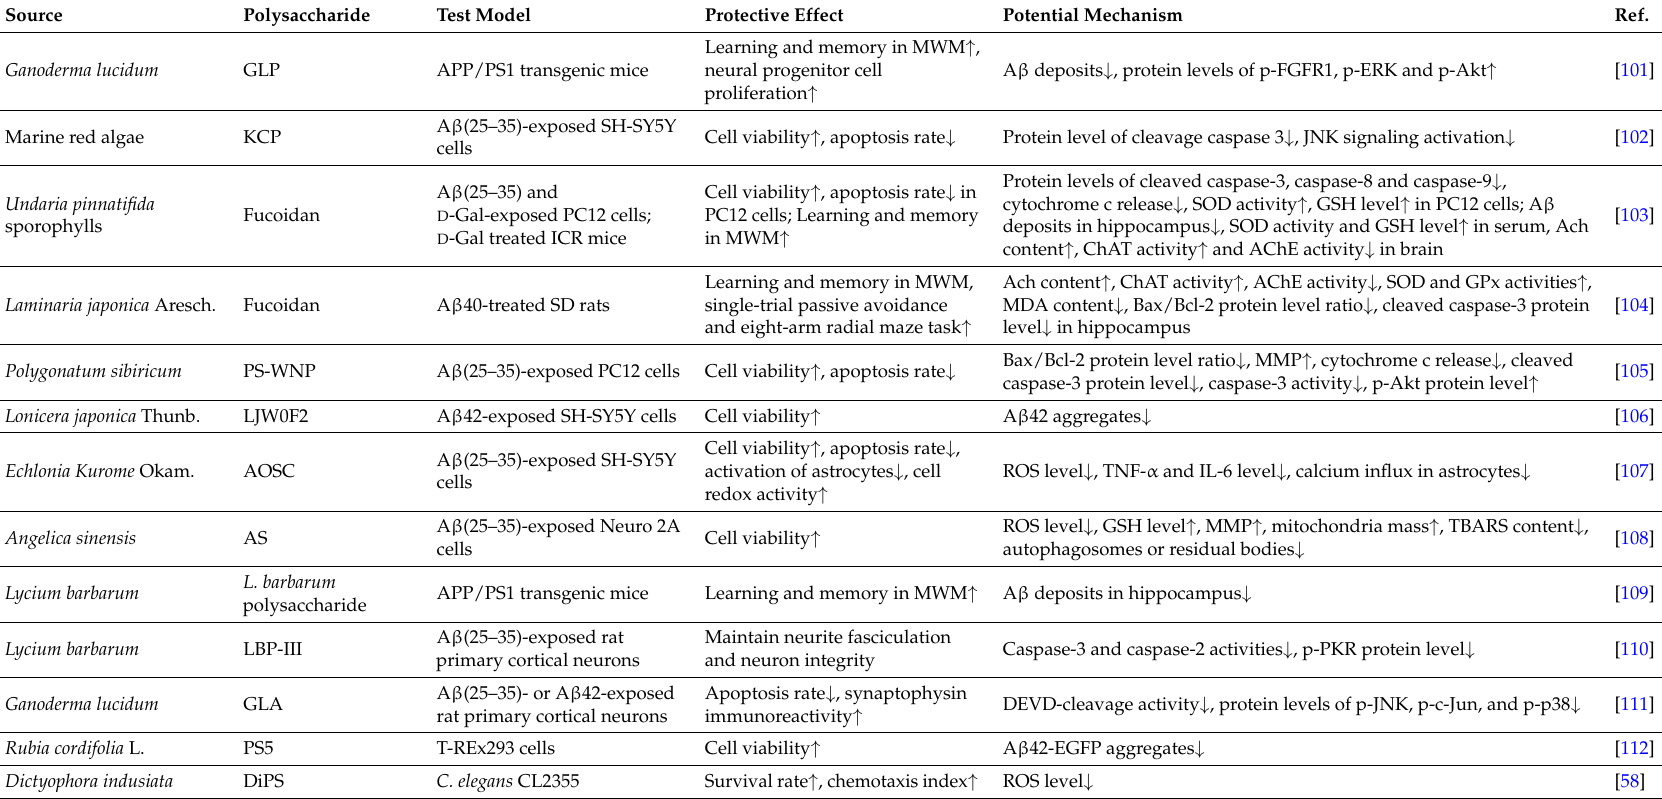
Table 2. Protective effects and mechanisms of food-derived antioxidant polysaccharides in neurodegeneration